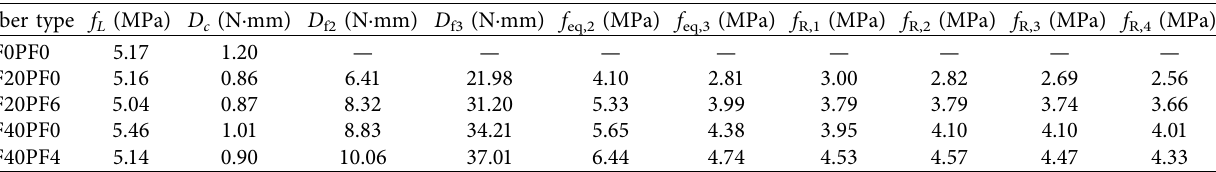
Figure 11: Load-defection curves of hybrid fber-reinforced self-consolidating concrete. Table 6: Te results of fexural strength and toughness of hybrid fber-reinforced self-consolidating